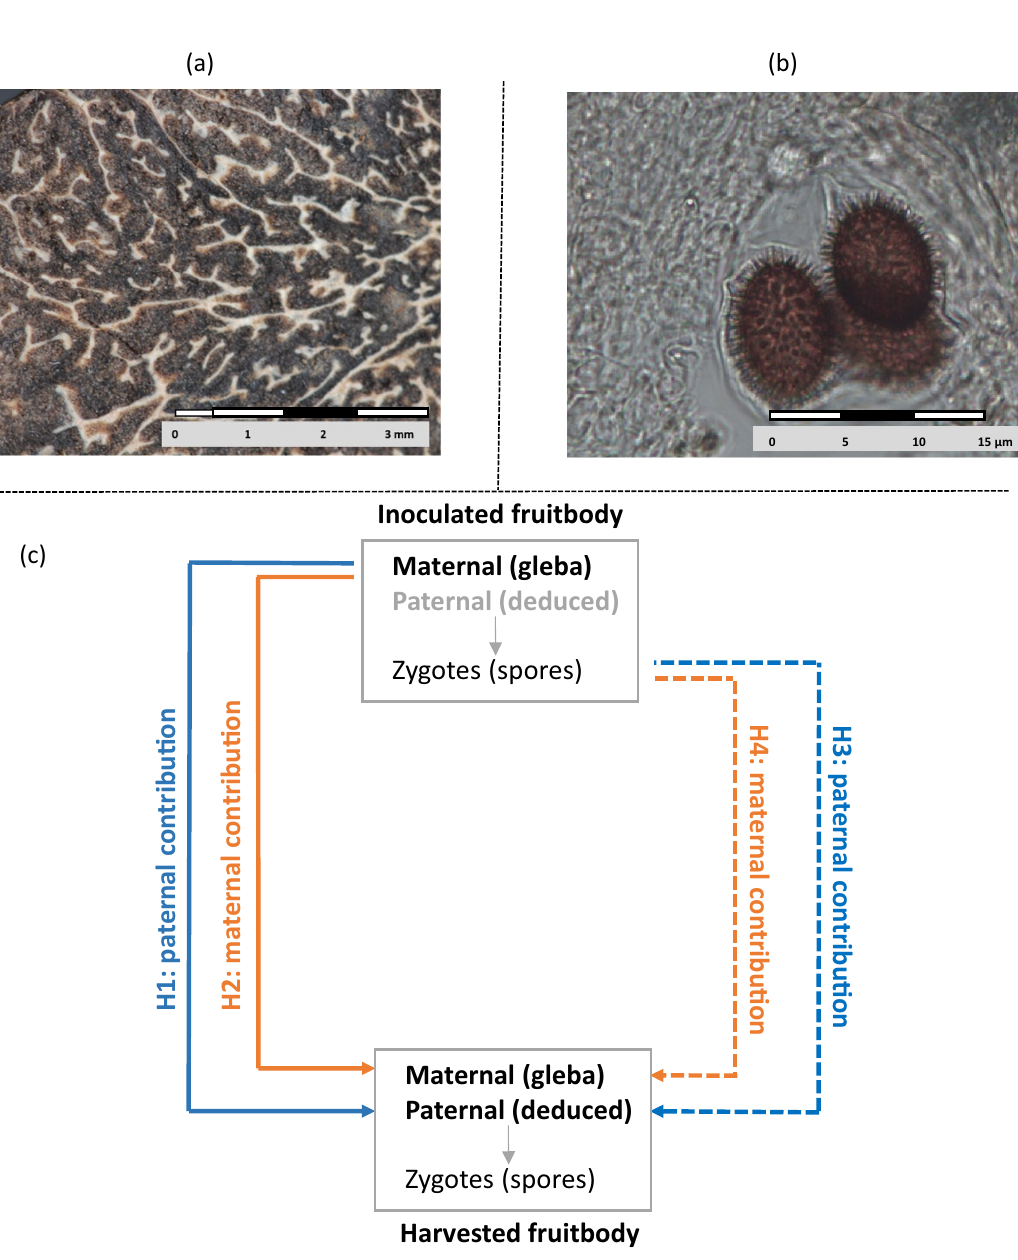
Figure 1. ( a ) Cut into a fresh T. melanosporum fruitbody showing the gleba (white flesh) which is the maternal individual, and the regions containing the meiotic spores (brownish parts). Photo credit G. Callot ( b ) Detailed view of T. melanosporum ascus containing spores under optical microscope. Photo credit F. Richard ( c ) Theoretical scenarii and corresponding hypotheses of the genetic contribution of T. melanosporum crushed fruitbody inoculum to the production of fruitbodies in truffle traps. Hypotheses H1 and H2 concern the potential contribution of the gleba from the inoculated fruitbody (continuous lines) to the harvested fruitbodies and hypotheses H3 and H4 concern the potential contribution of spores from the inoculated truffle (dotted lines). Both the gleba and the spores can have either a paternal contribution (blue) or maternal contribution (orange) to the harvested fruitbody. Hypotheses H1 and H2 were tested by direct multilocus genotype comparisons whereas hypotheses H3 and H4 were tested by relatedness